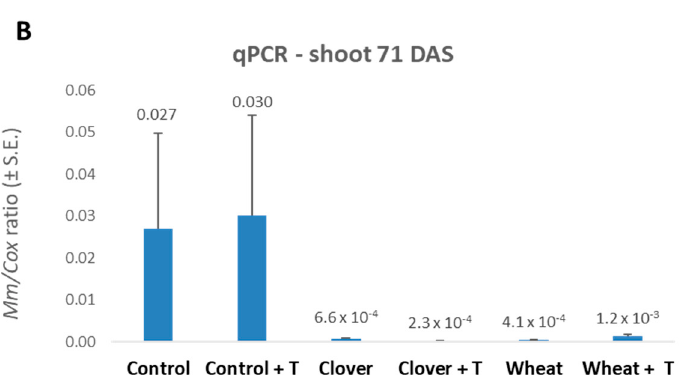
Figure 7. The 2020 commercial fields soil experiment—real-time PCR analysis 71 DAS. The experi- ment is described in Figure 2. The y -axis indicates M. maydis relative DNA abundance in the roots normalized to cytochrome c oxidase ( COX ) DNA. Values indicate an average of 10–12 replications. Error bars indicate standard error.